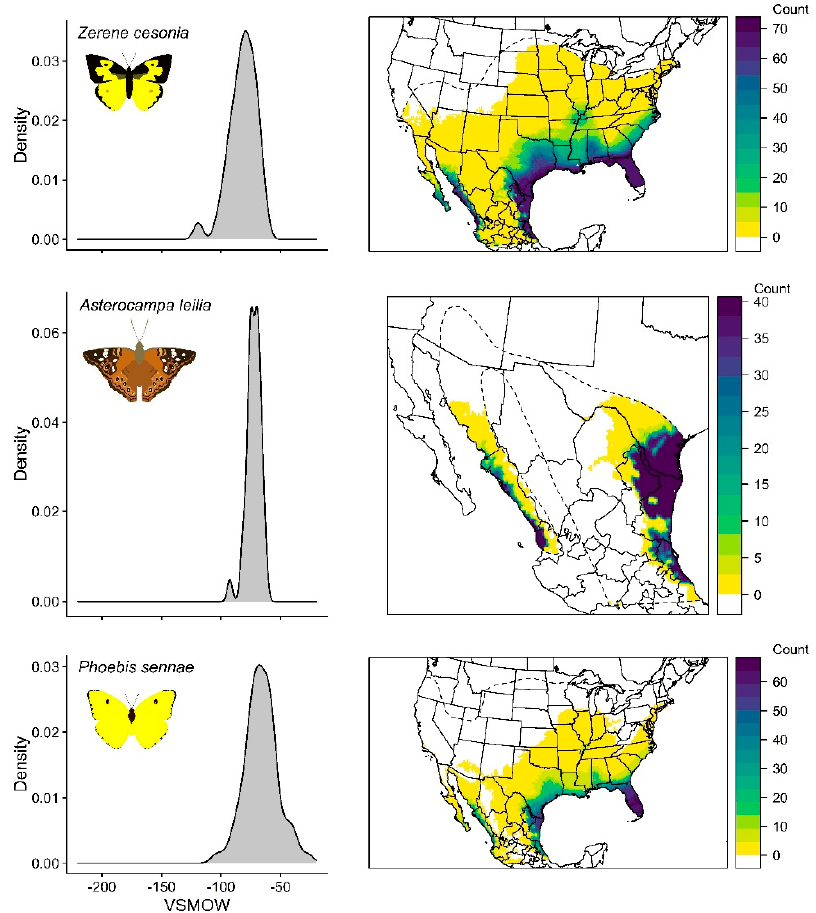
Figure 4. Probabilistic assignment to origin for three (shorter-distance) species of butterfly intercepted during fall migration in northeast Mexico, 2019. The figure key refers to the number of individuals assigned per pixel according to a 2:1 odds criterion (see Methods).